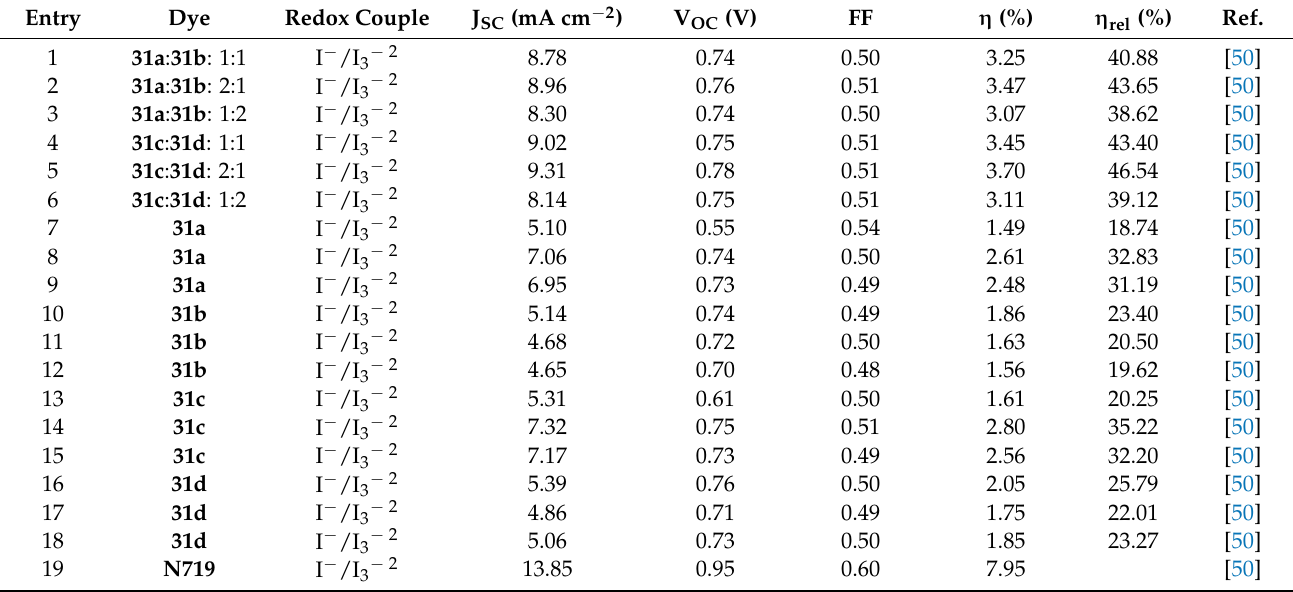
Table 7. Photovoltaic data of DSSCs produced with dyes 31a – d 1